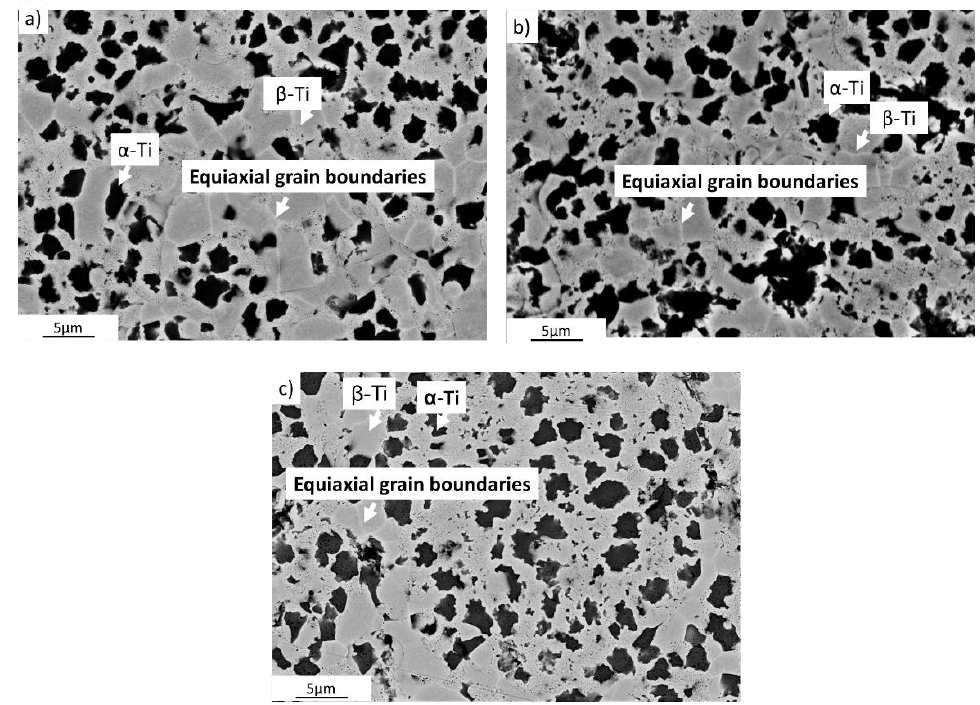
Figure 8. SEM images of the sintered samples of Ti-34Nb-6Mo obtained at ( a ) 40 h, ( b ) 60 h and ( c ) 40 h of direct